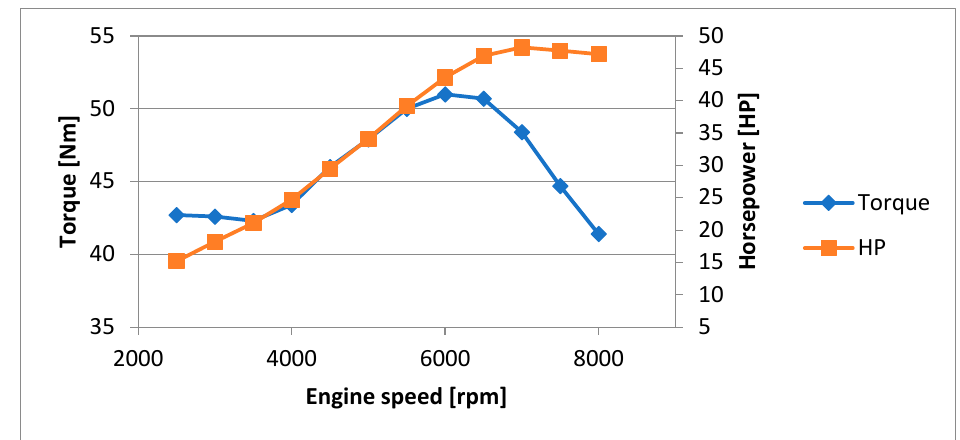
Figure 6. ICE horsepower − torque curve.